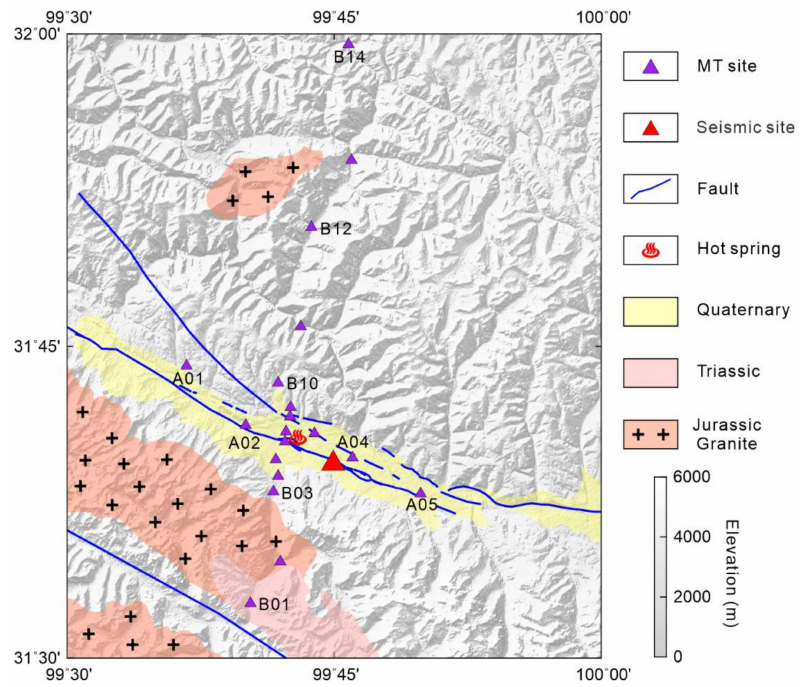
Figure 3. Geological structure map of the study region with topographic relief and magnetotelluric sites indicated as purple triangles. The blue solid and dotted line represents